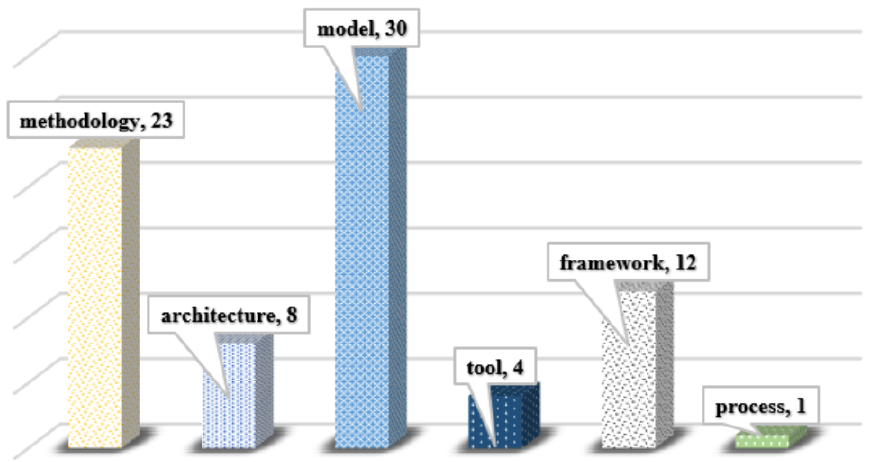
Figure 11. Comparison of contribution type.